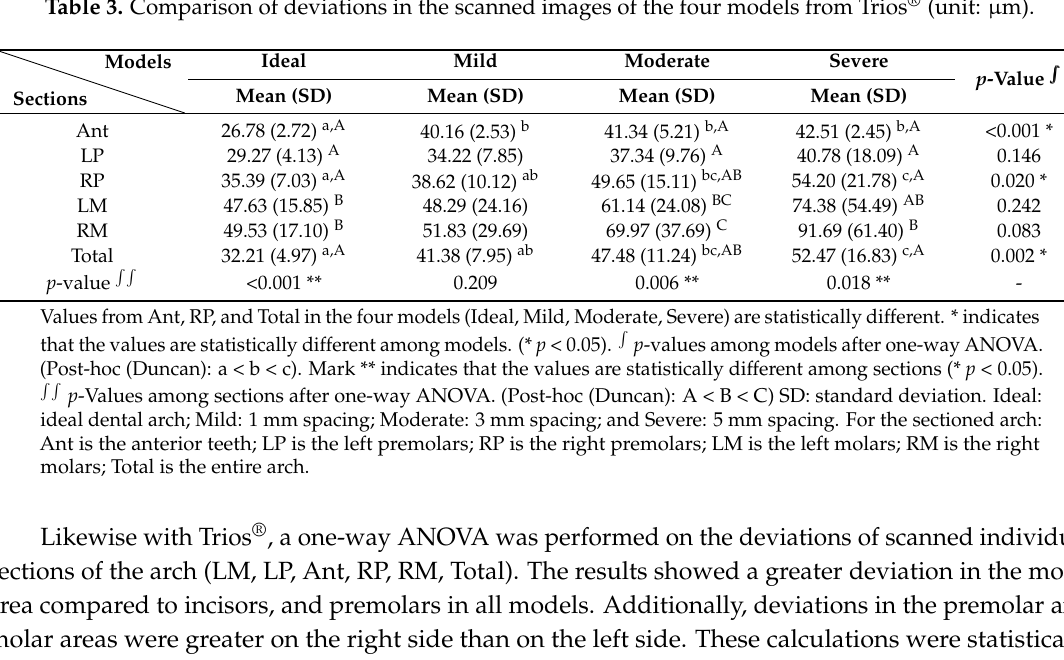
Table 3. Comparison of deviations in the scanned images of the four models from Trios ® (unit: µ